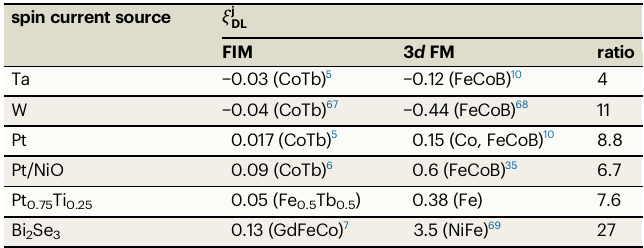
for FIMs and 3 d FMs in contact DL and T SH int